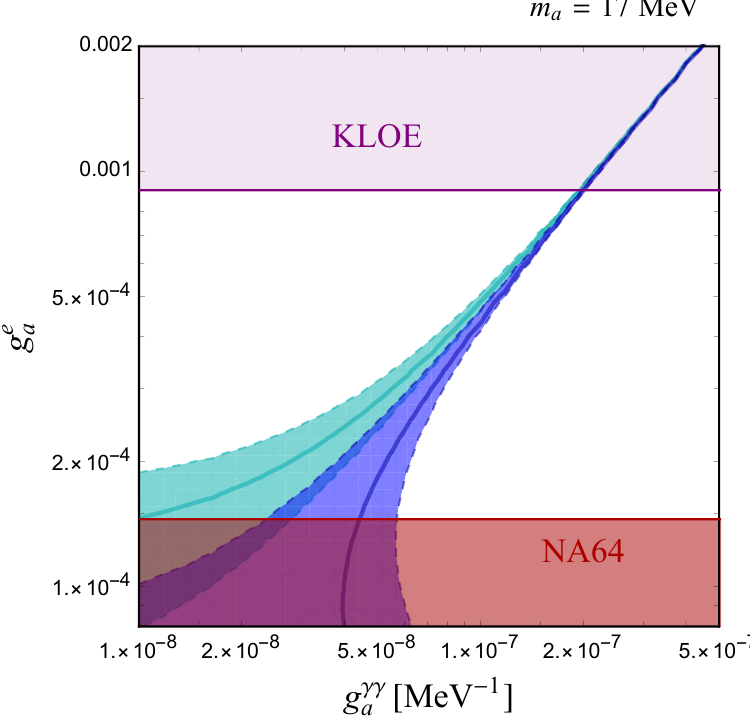
Figure 2 . Parameter space for the 17 MeV axion which can accommodate ( g − 2) e . The purple and red shaded regions are excluded by KLOE and NA64 respectively [34, 38]. The cyan region is consistent at the 95% C.L. with the deviation ∆ a e obtained from eq. (3.1). The blue region shows the 95% C.L. region consistent with the value inferred from the recent measurement of the fine structure constant, reported in